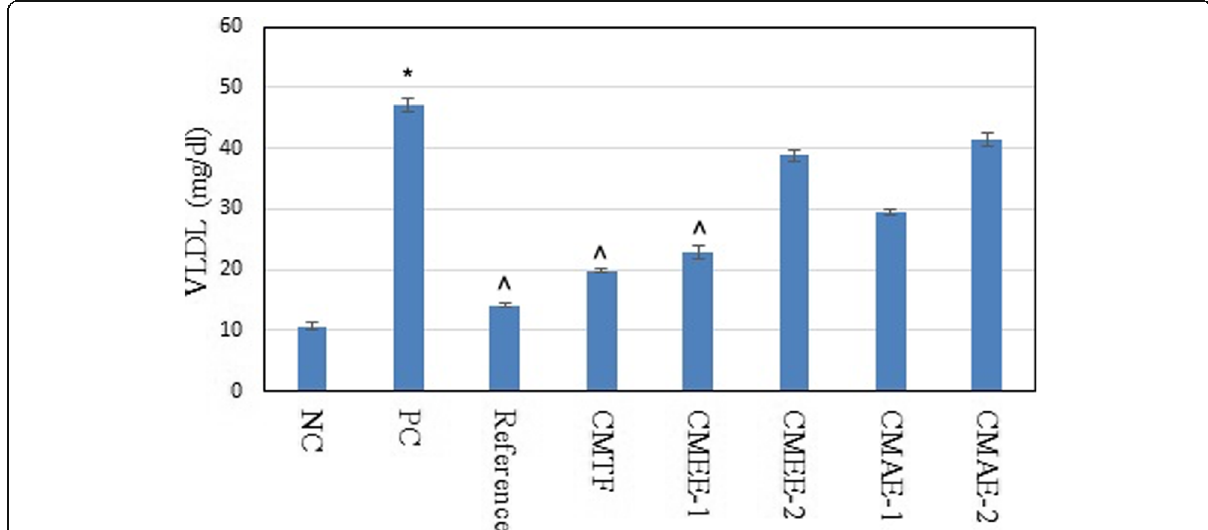
Fig. 4 Effect of C. melo fraction and extracts on the VLDL level of animals. Values are expressed as mean ± standard error of mean ( n = 6), significantly different at * P < 0.05, vs the normal control group; △ P < 0.05, vs the diabetic control group analyzed by one-way ANOVA followed by Tukey ’ s multiple comparison test. CMTF, Cucumis melo toluene fraction (ethanolic extract); CMEE 1, Cucumis melo ethanolic extract (400 mg/kg); CMEE 2, Cucumis melo ethanolic extract (200 mg/kg); CMAE, Cucumis melo aqueous extract (400 mg/kg); CMAE, Cucumis melo aqueous